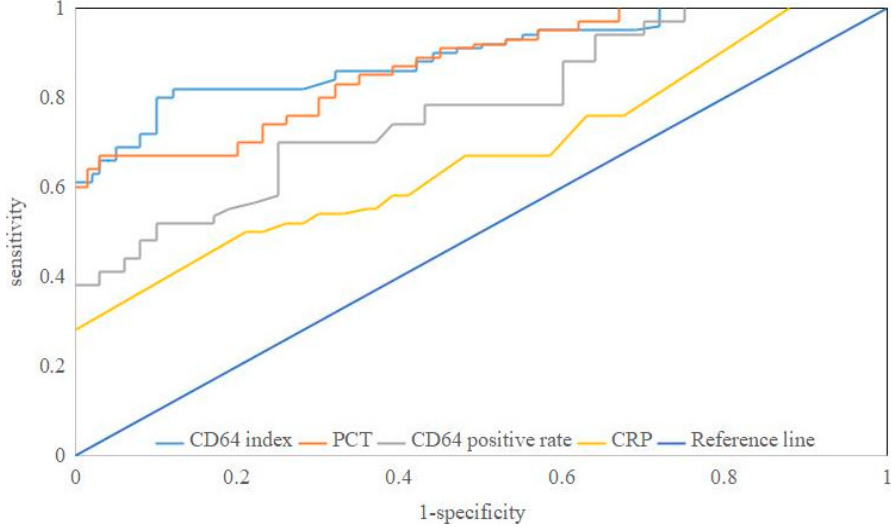
Figure 1. ROC curve of infection indicators for the diagnosis of acute pancreatitis with abdominal infection.